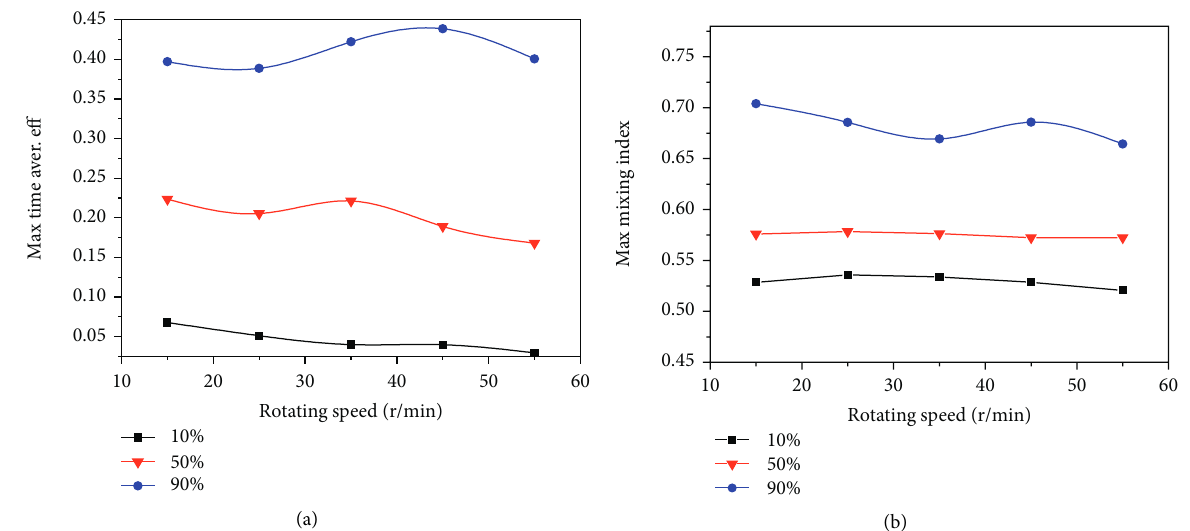
Figure 8: Influence of rotor rotational speed on the maximum time averaged efficiency (a) and mixing index (b).